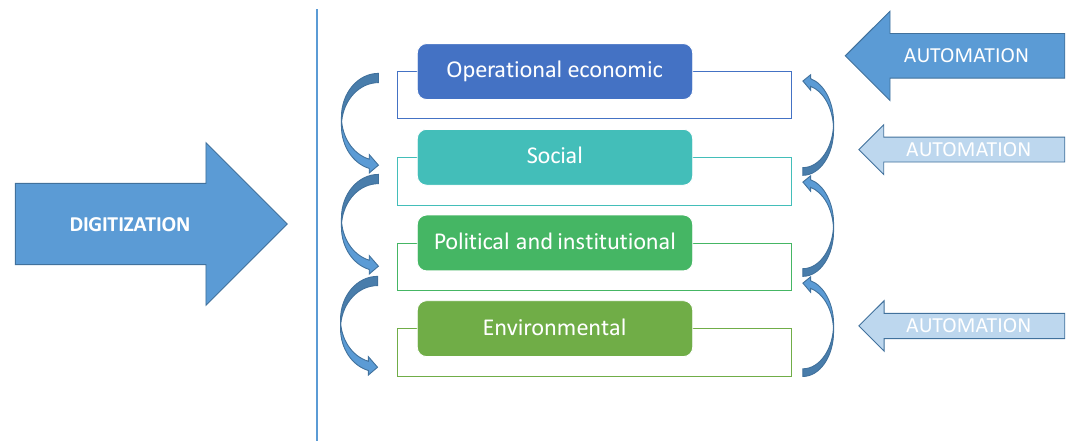
Figure 2. Scheme including automatization concept.